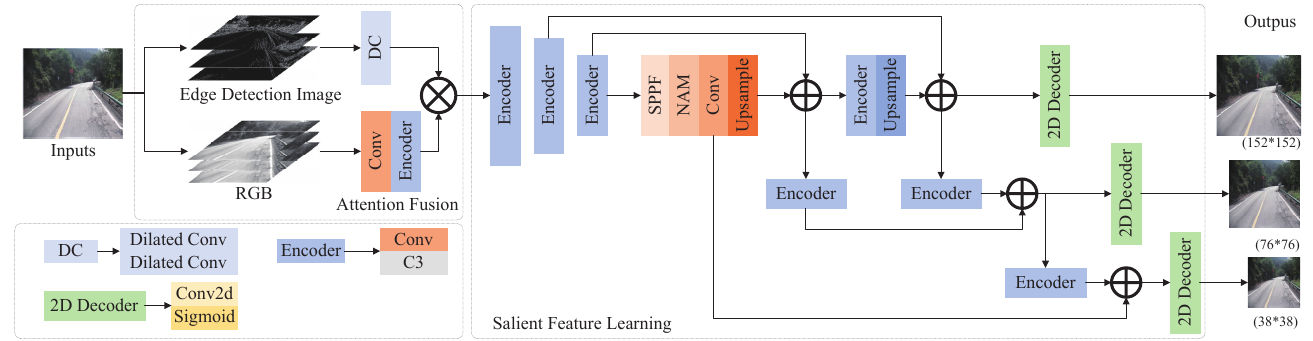
Figure 5. Outline of the proposed